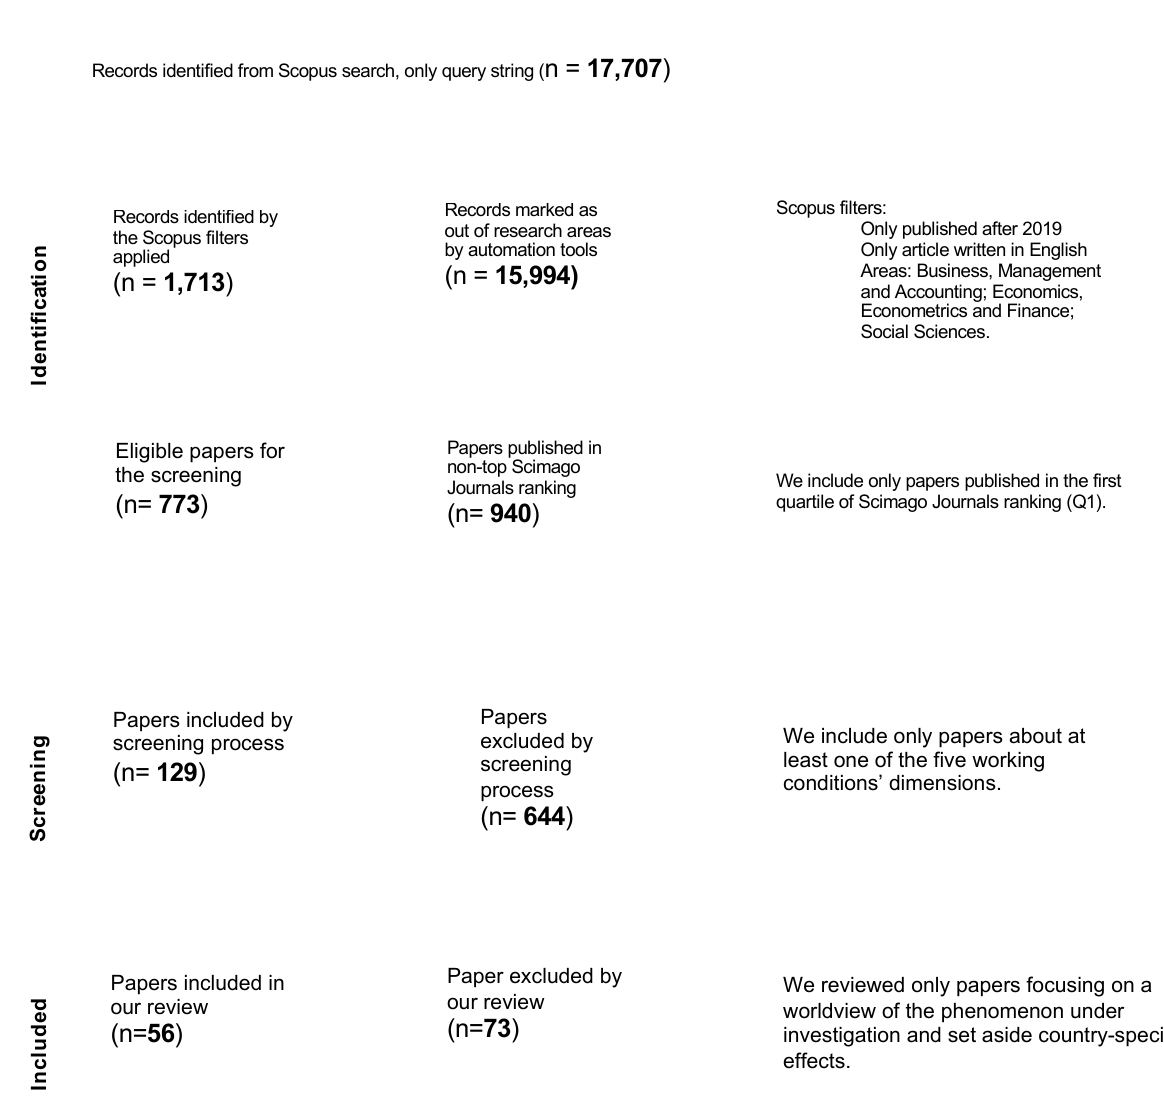
Figure 1. Systematic Literature Review process.